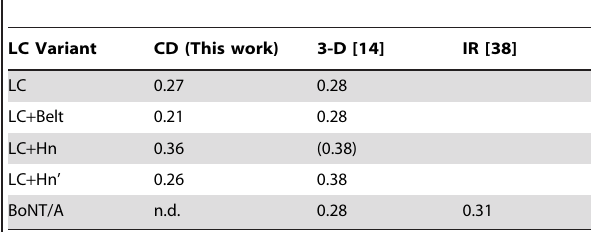
Table 1. Helical content of LC variants compared with values derived from three-dimensional (3-D) and infrared (IR)